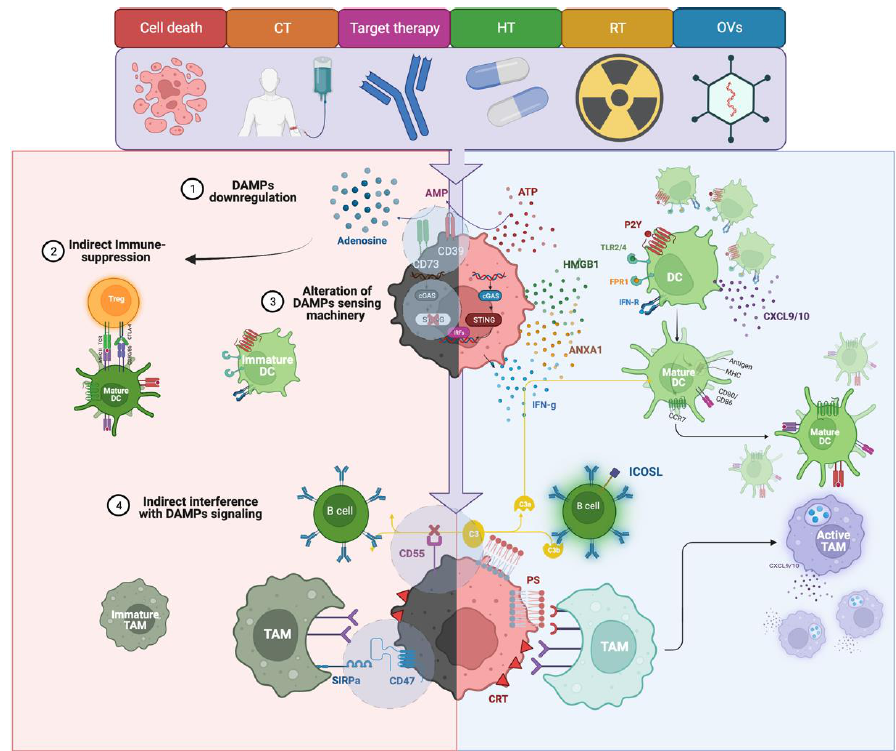
Figure 2. Multiplexed spatial protein profiling of adjuvanticity patterns in breast cancer. On the right side: The positive effects of regulated cell death and damage-associated molecular patterns (DAMPs) released in recruiting and activating dendritic cells (DCs), and tumor-associated macrophages (TAMs), in the tumor microenvironment (TME); further, phosphatidylserine (PS)-mediated activation of the complement system can stimulate B cells expression of ICOSL. On the left side: Some of the critical mechanisms of DAMP interference: ( 1 ) DAMPs’ downregulation: ATP concentrations can be limited by CD39/CD73 coordinated action, which can limit both ATP-induced adjuvanticity and favor adenosine-mediated immunosuppression; ( 2 ) indirect immune suppression: an indirect mechanism can interact with an effective priming, such as FOXP3+ regulatory T cell (Treg) differentiation, which can interfere with mature DC migration to tumor-draining lymph nodes (see DCs section); ( 3 ) alteration of DAMPs sensing machinery: STING downregulation can impair the sensing of free cytoplasmic DNA and thus STING-mediated IFN- γ signaling; ( 4 ) indirect interferences with DAMP signaling: CD47 expression can inhibit TAMs-mediated phagocytosis and therefore indirectly limit calreticulin and phosphatidylserine (PS) activity. CD55 can interfere with PS-induced complement- dependent cytotoxicity (CDC) and CDC-induced B cell differentiation into ICOSL+ B cells. Created with